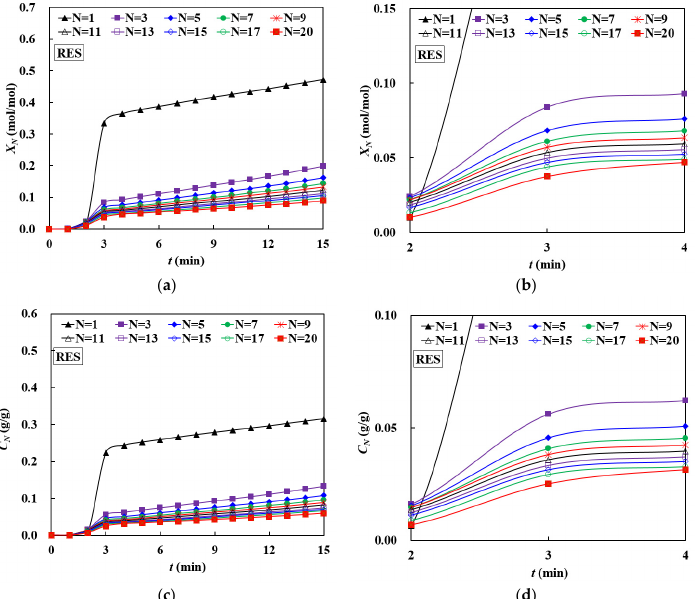
Figure 7. CO 2 capture characteristics of RES during different cycle number: ( a ) relationship between X N and N; ( b ) zoom of ( a ); ( c ) relationship between C N and N; ( d ) zoom of ( c ). As shown in Figure 5, the decay of X N of APC with an increase in cycle number was less significant than CS and RES. X N reached a maximum value of 0.747 mol/mol during Cycle 1 and subsequently decreased continuously to 0.591 mol/mol after Cycle 20; a 20.87% decrease compared with Cycle 1. From Figure 8, it can be seen that the degrees of carbonation at a reaction time of 3 min were similar among the various cycles. This may be because the rapid chemical reaction-controlled stage was mainly influenced by reaction temperature and external surface area, which limited the influence of sintering-induced micropore structure changes after multiple cycles on the degree of carbonation in APC during this stage. The X N values after 3 min of reaction for the various cycles exhibited significant changes with an increase in reaction time. At a reaction time of 15 min, the values of X N and C N were 0.492 mol/mol and 0.377 g/g during Cycle 1; the corresponding values for Cycle 20 were 0.378 mol/mol and 0.292 g/g, and the difference between the maximum and minimum X N values and difference between the maximum and minimum C N values for APC were 0.156 mol/mol and 0.120 g/g, respectively.